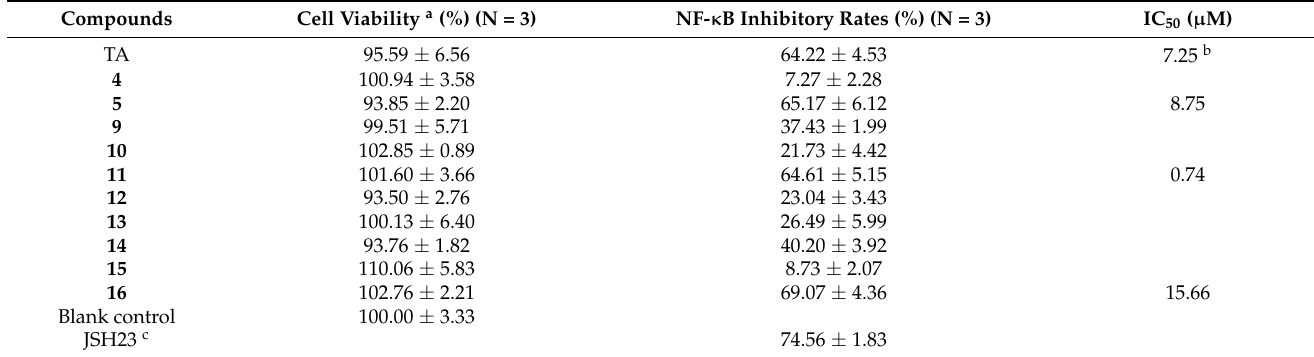
Table 3. NF- κ B inhibitory effects of TA, 4 , 5 , and 9 – 16 in the HEK293/NF- κ B-Luc cells induced by LPS. Compounds Cell Viability a (%) (N = 3) NF- κ B Inhibitory Rates (%) (N = 3) IC 50 ( µ